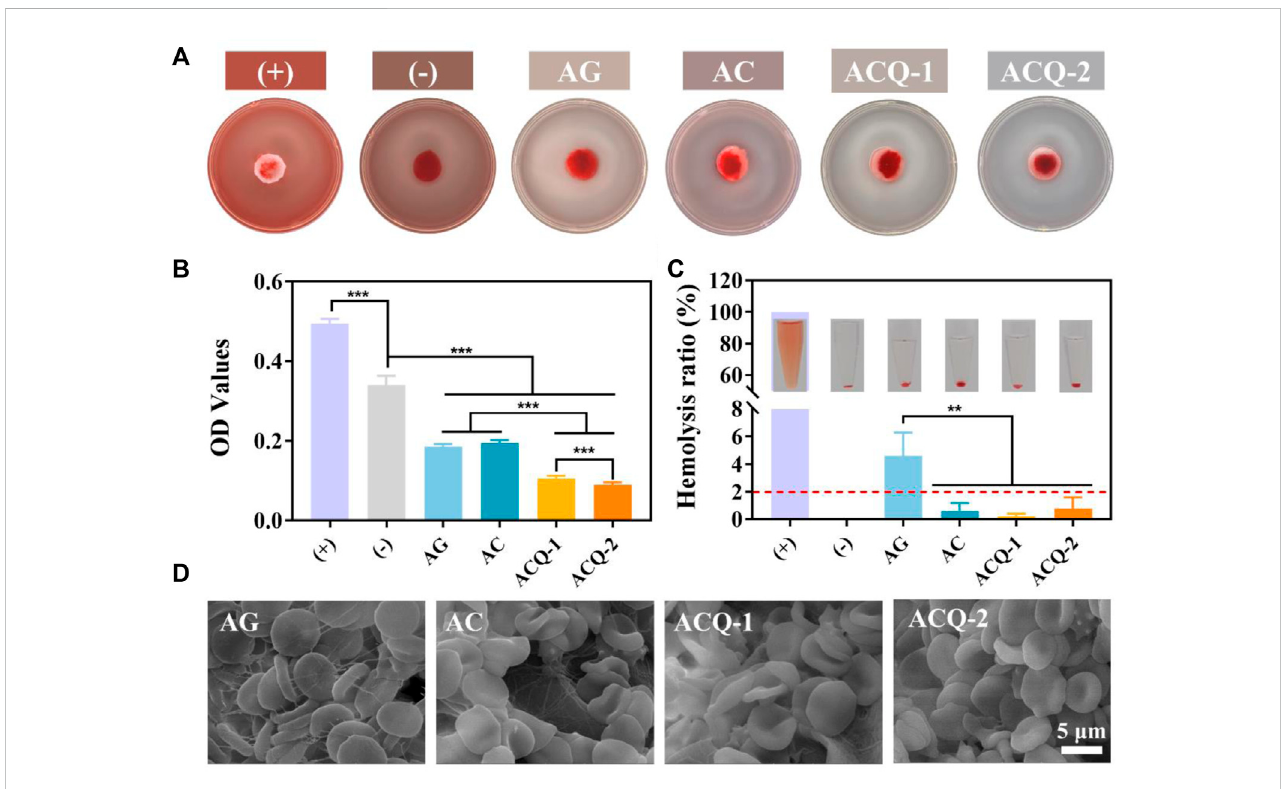
FIGURE 6 (A) Pictures and (B) quantitative results of blood coagulation experiments. (C) Photographs and quanti fi cation of hemolysis test. (D) SEM images of RBC adhering to sponges. Data are mean ± SD (n = 3) (** p < 0.01, *** p <